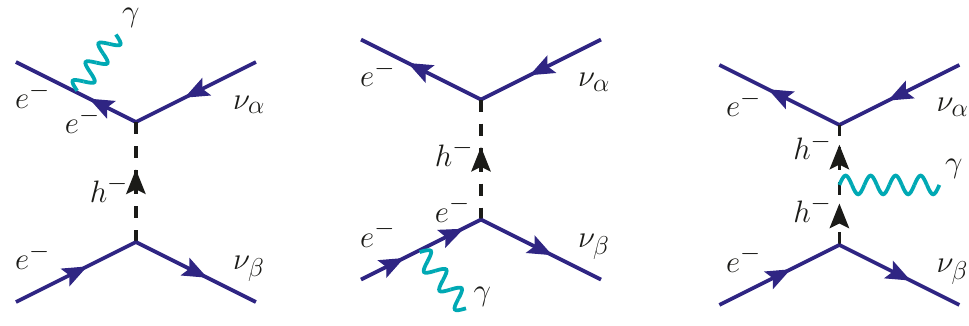
Figure 16 . Feynman diagrams for charged scalar contributions to monophoton signal at